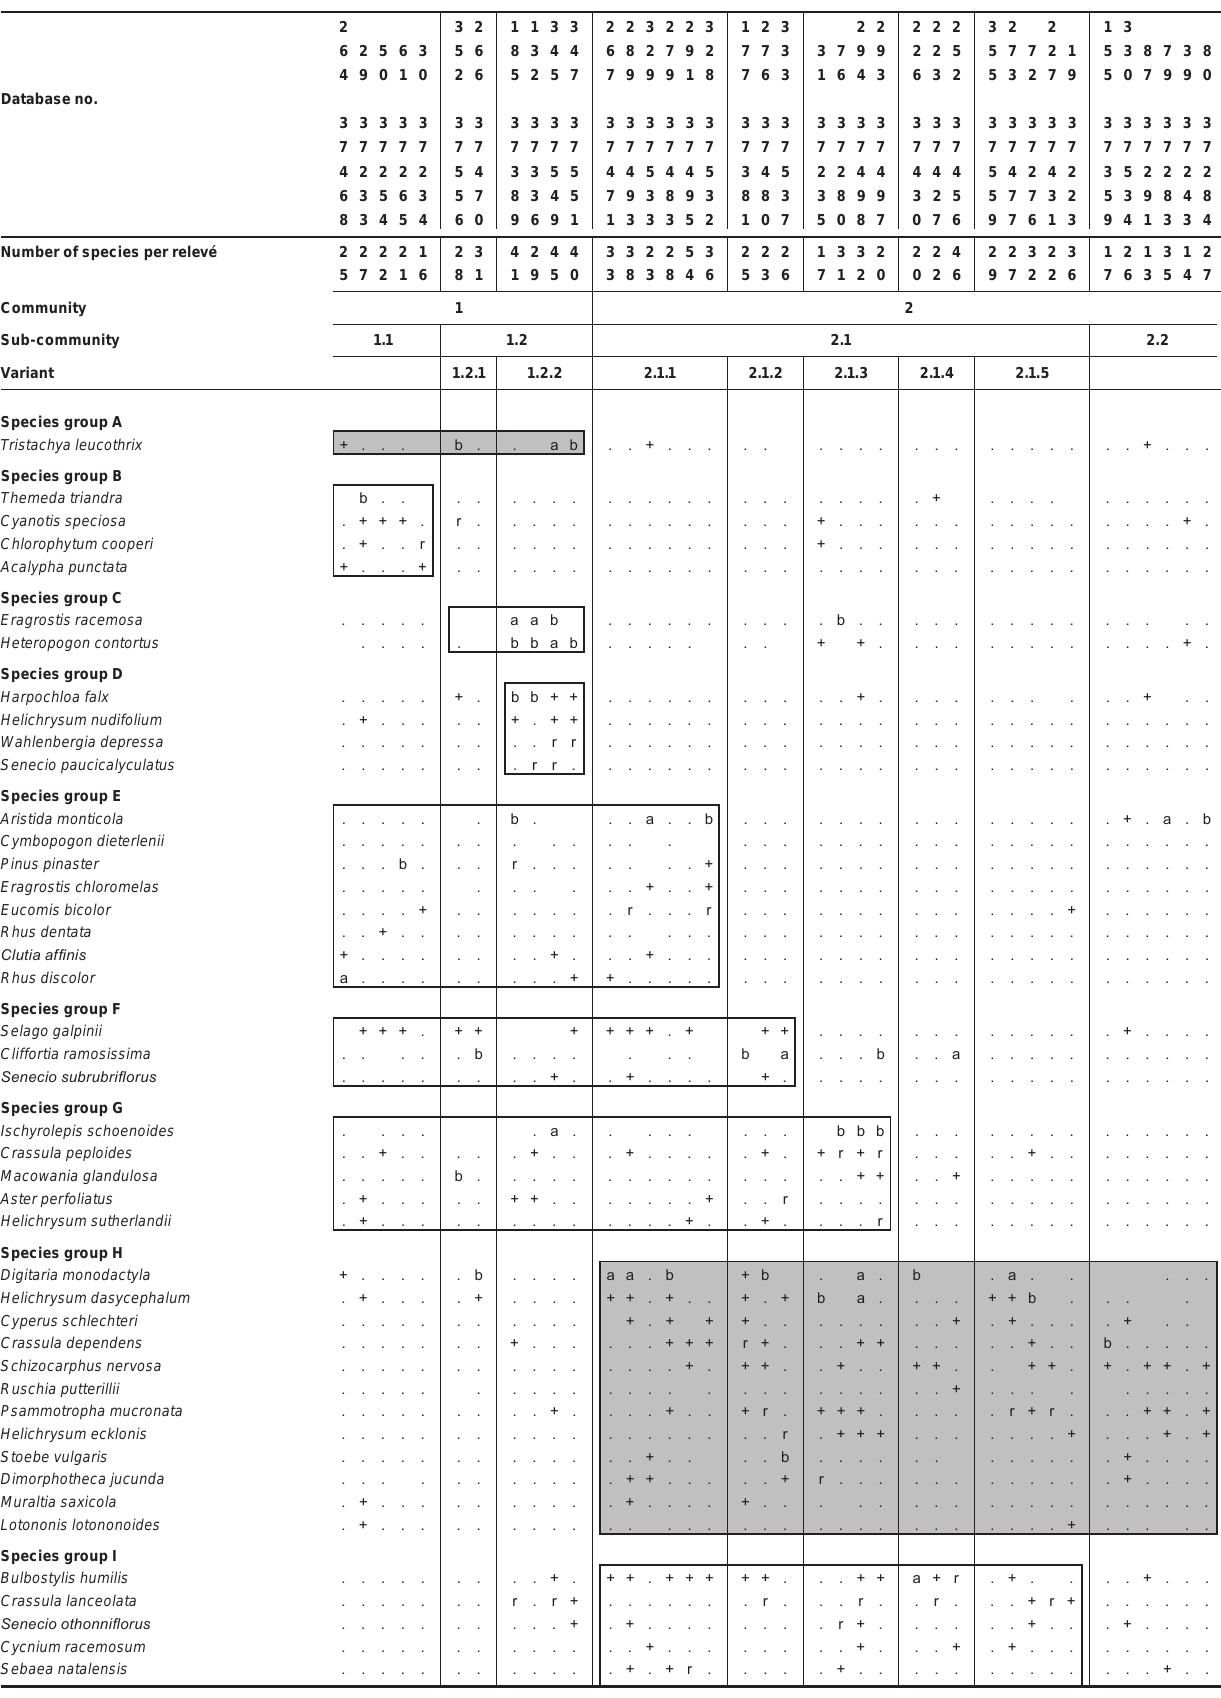
TABlE 1 Fynbos Communities of Platberg, Eastern Free